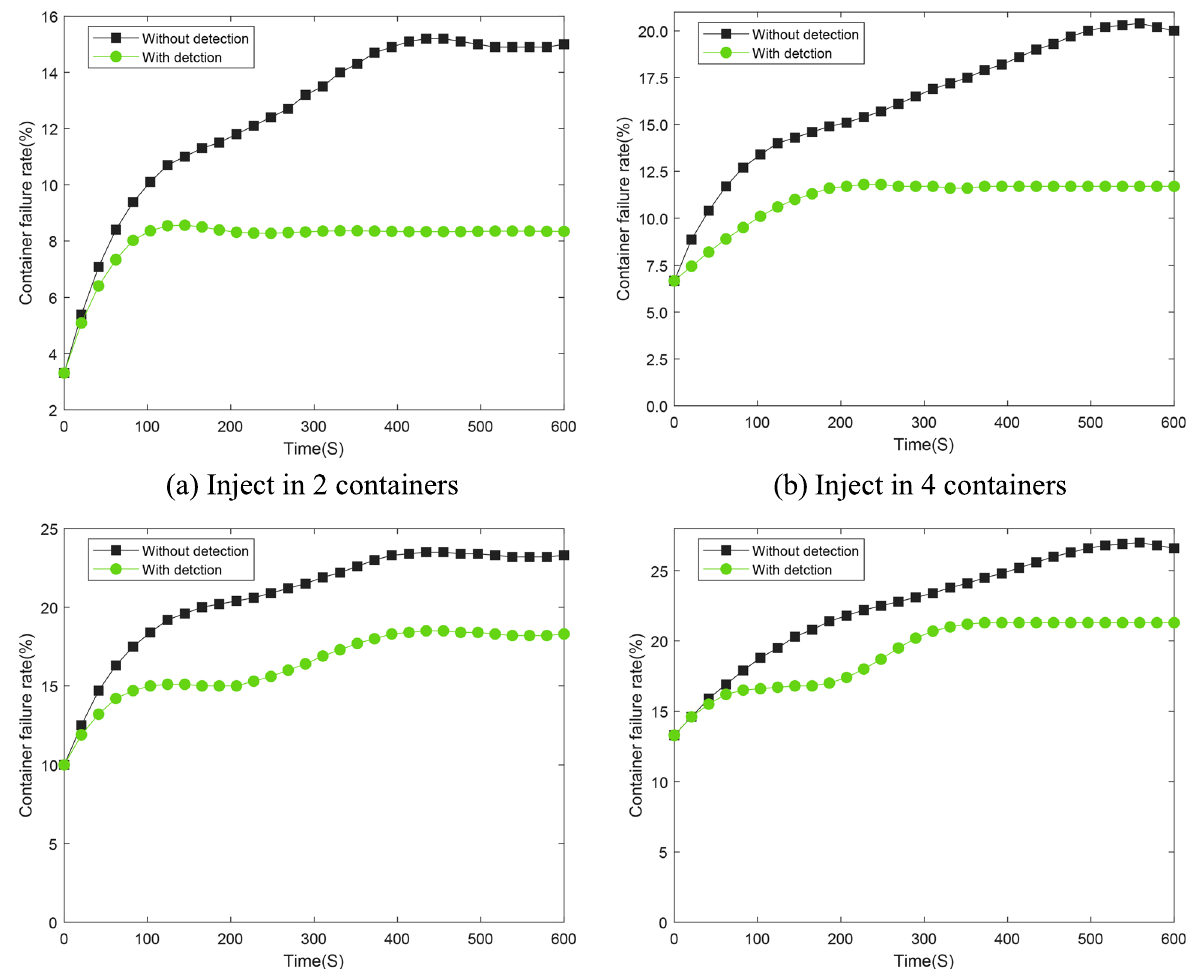
Fig. 17 Fault propagation rate